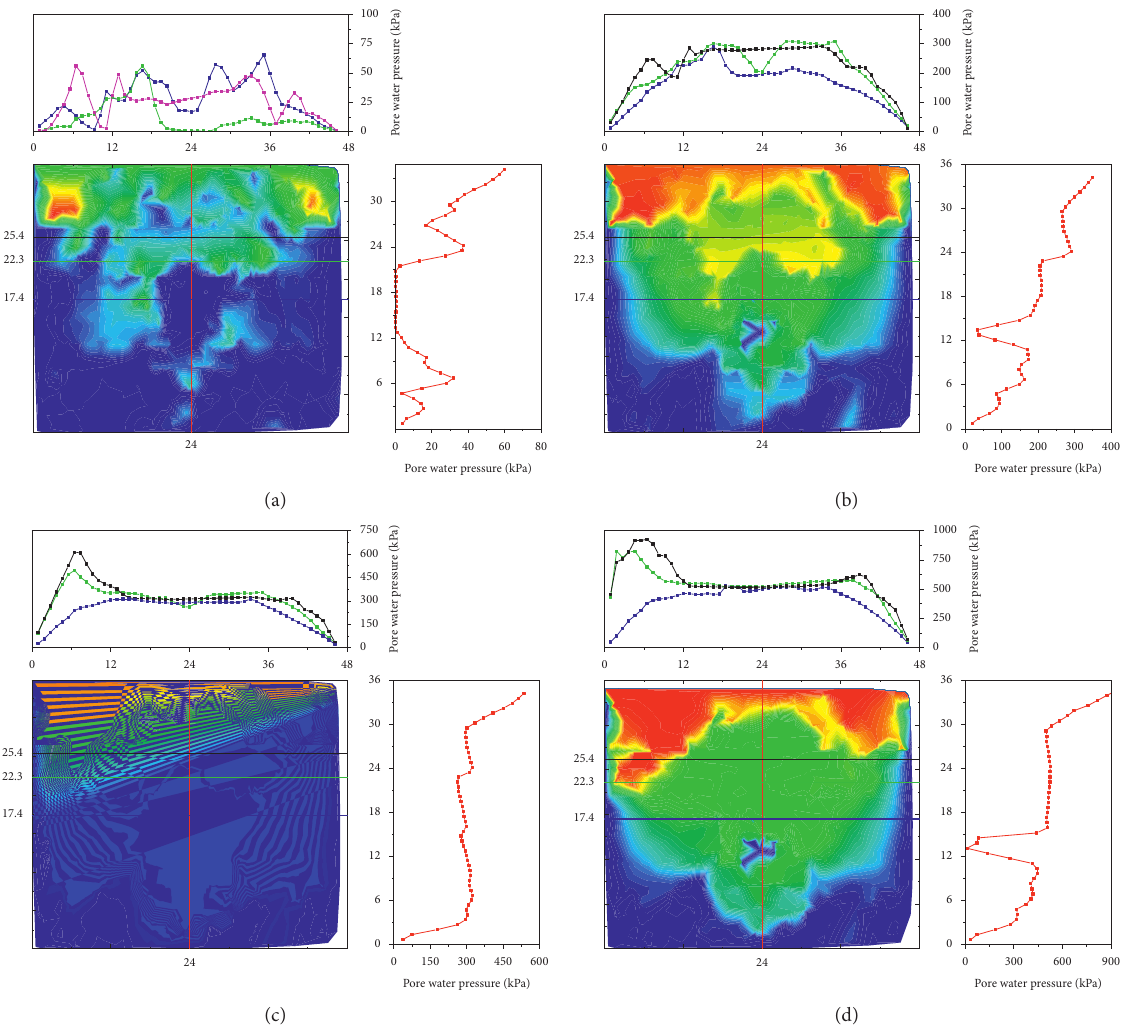
Figure 12: Nephogram of pore-water pressure and pore-pressure survey-line data. (a) 0.1MPa water pressure. (b) 0.4MPa water pressure. (c) 0.6MPa water pressure. (d) 1MPa water pressure.